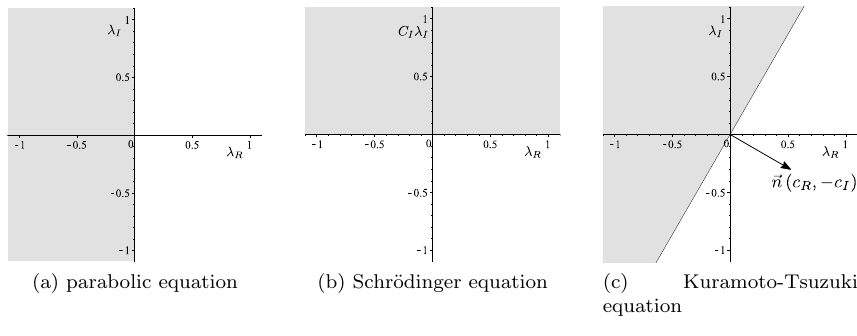
Figure 1. Stability regions of a) parabolic equation, b) Schr¨odinger equation, c) Kuramoto-Tsuzuki